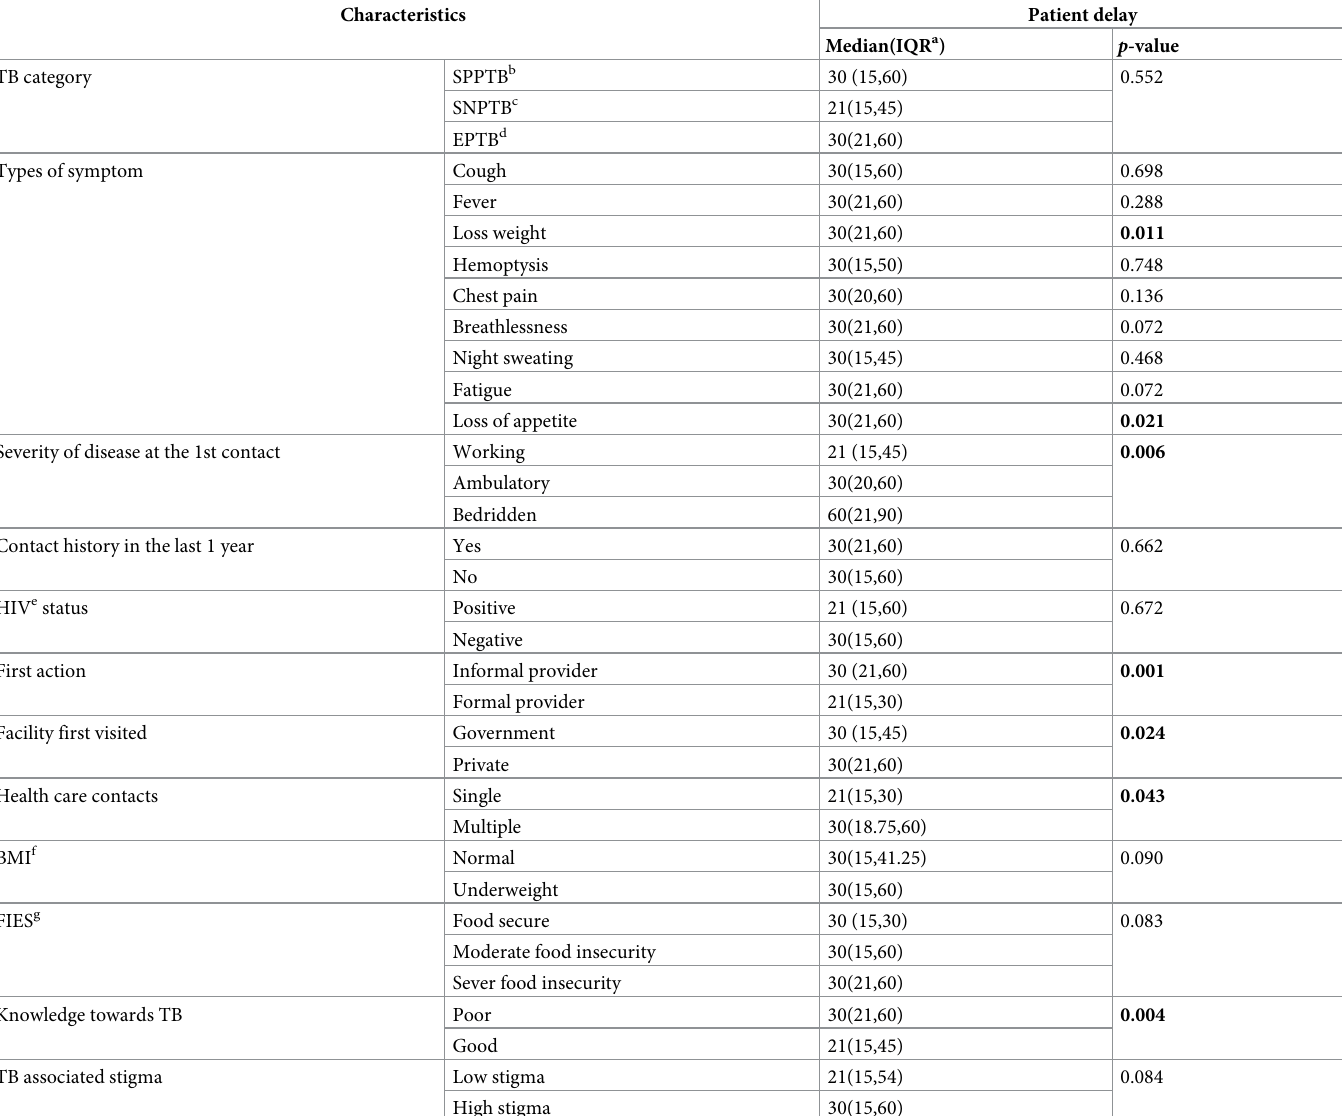
Table 4. Distribution of patient delay by socio-demographic, clinical variables and health-seeking trajectories, nonparametric (Mann–Whitney and Kruskal-Wallis) test (Continued)